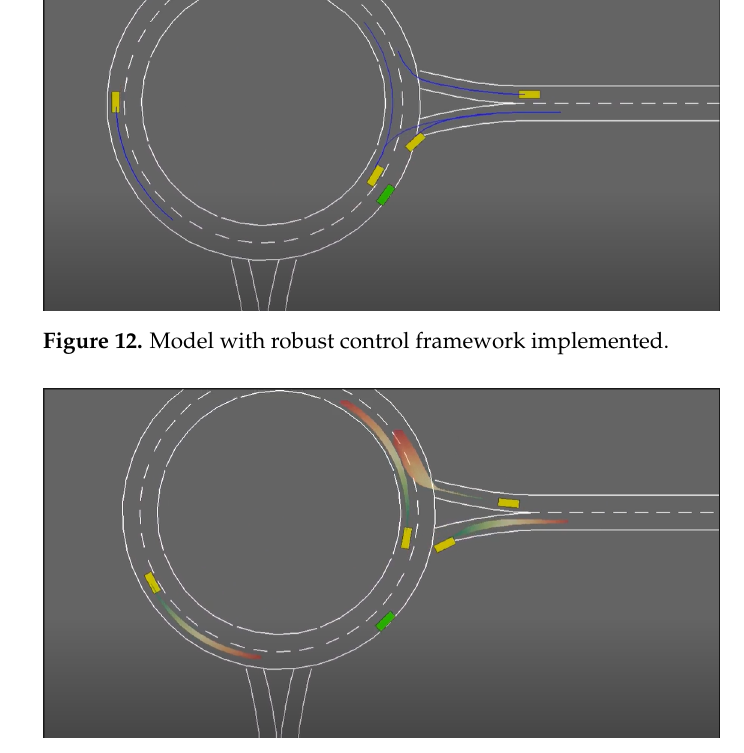
Figure 13. Robust control with continuous ambiguity to predict trajectories of surrounding